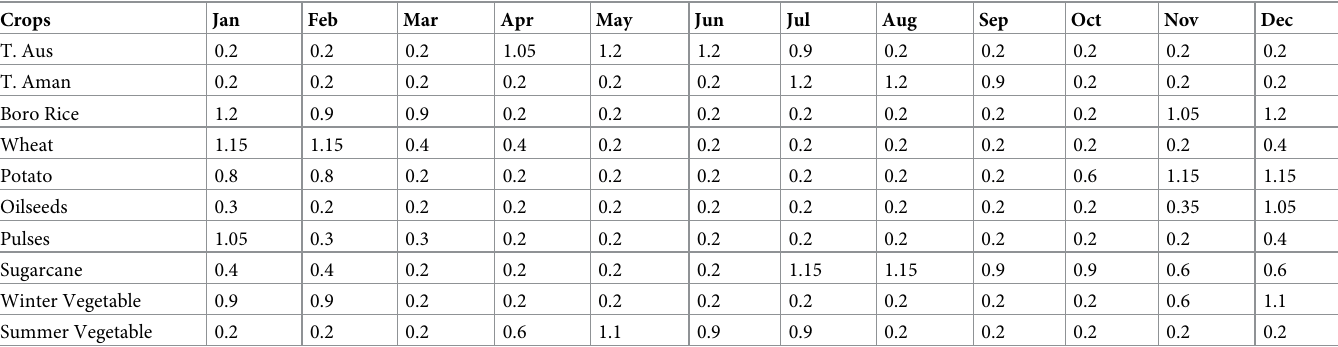
Table 4. Crop coefficient k c , m